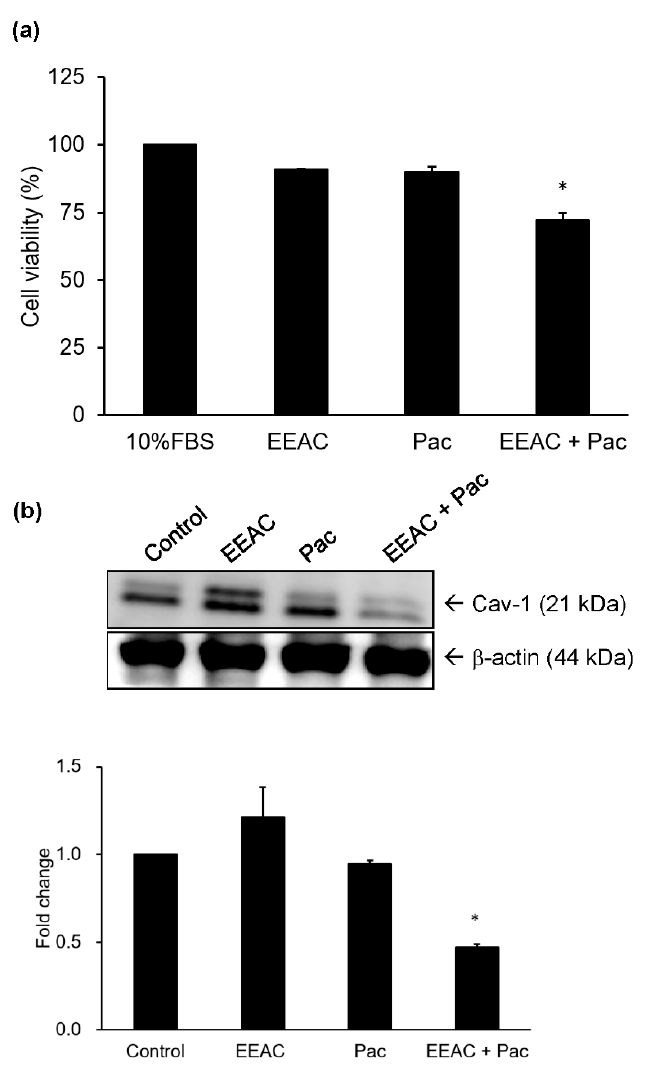
Figure 6. EEAC enhanced chemosensitivity of A549 cell to paclitaxel. Cells were incubated with EEAC (6.25 µ g/mL), paclitaxel (0.156 µ M; Pac) or EEAC combined with paclitaxel for 24 h to examine the change of cell viability ( a ). Under the same experimental condition, the expression level of cav-1 protein was examined using Western blot ( b ). The band intensities of each group were quantified and normalized to the control group, and the relative expression of cav-1 protein was presented as fold change in a histogram. * indicates p < 0.05 as compared with paclitaxel alone group. Pac, paclitaxel; Cav-1, caveolin-1.